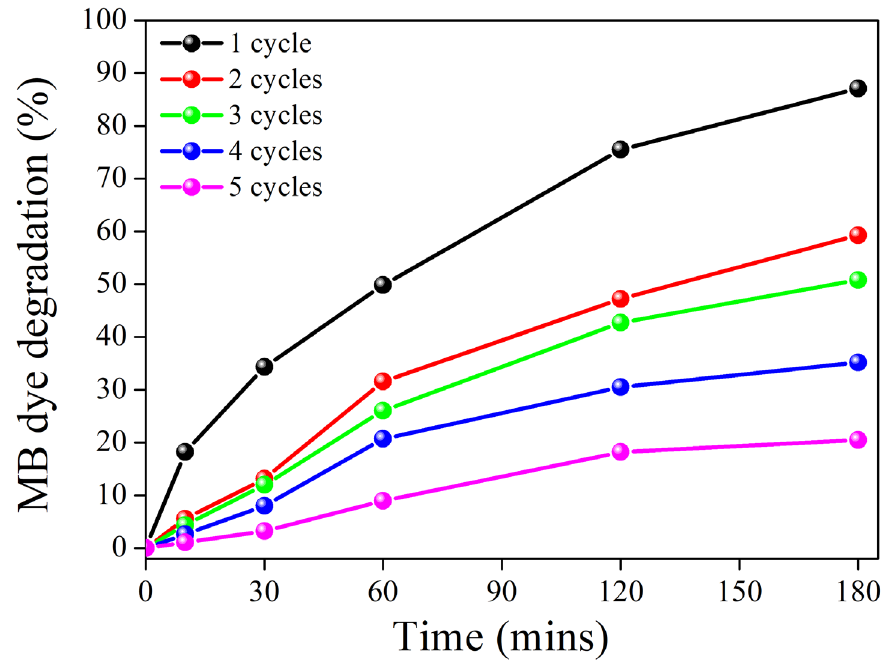
Figure 9. Cyclic testing of PLIP-synthesized magnetic Fe3O4 NPs in MB photodegradation under white-light exposure.